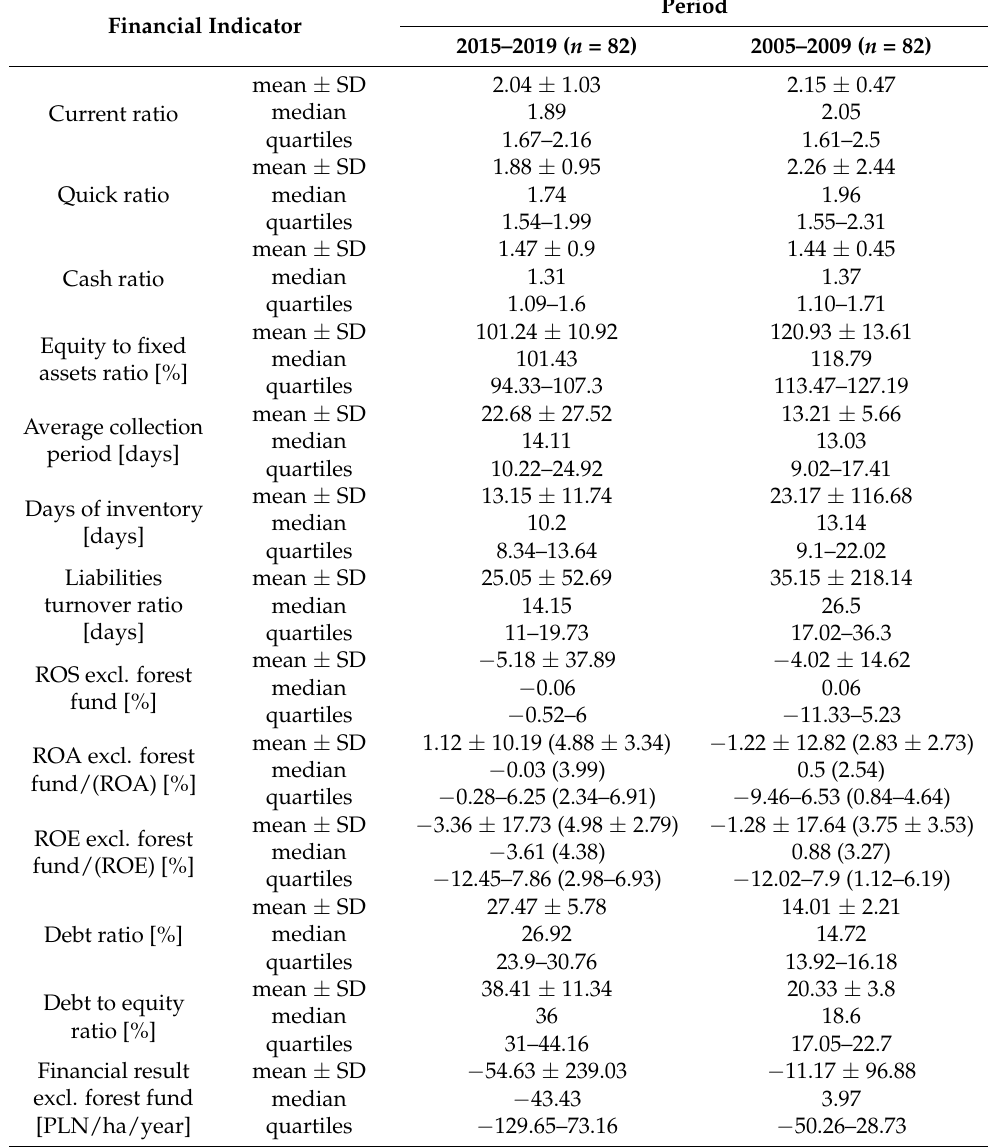
Table 2. Means, medians, and quartiles for the liquidity, activity, profitability, and debt ratios as well as the financial results of the studied forest